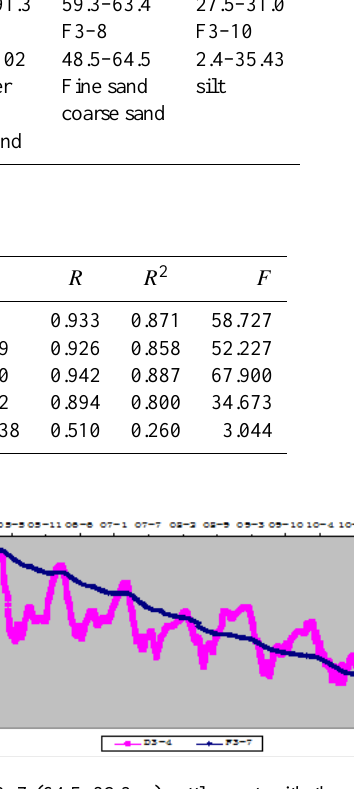
Figure 2. F3–7 (64.5–82.3m) settlement with the water level ele- vation of D3–4 in Tianzhu